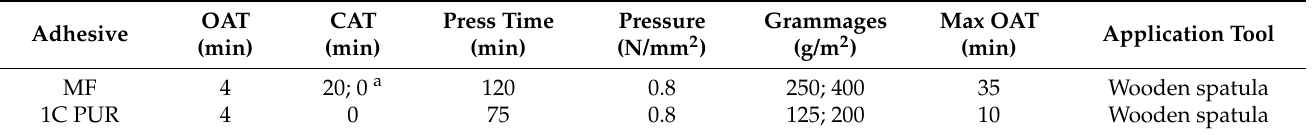
Table 3. Glueing parameters and adhesive information at 20 ◦